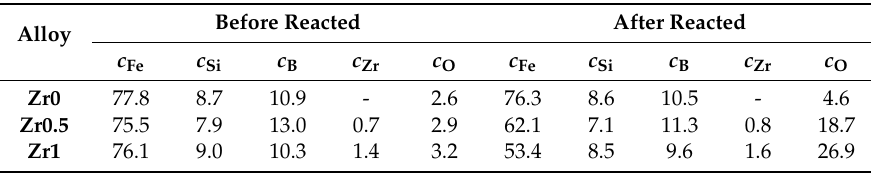
Table 1. Energy dispersive X-ray spectrometer (EDS) analysis of the Zr0, Zr0.5 and Zr1 ribbons before and after reacted